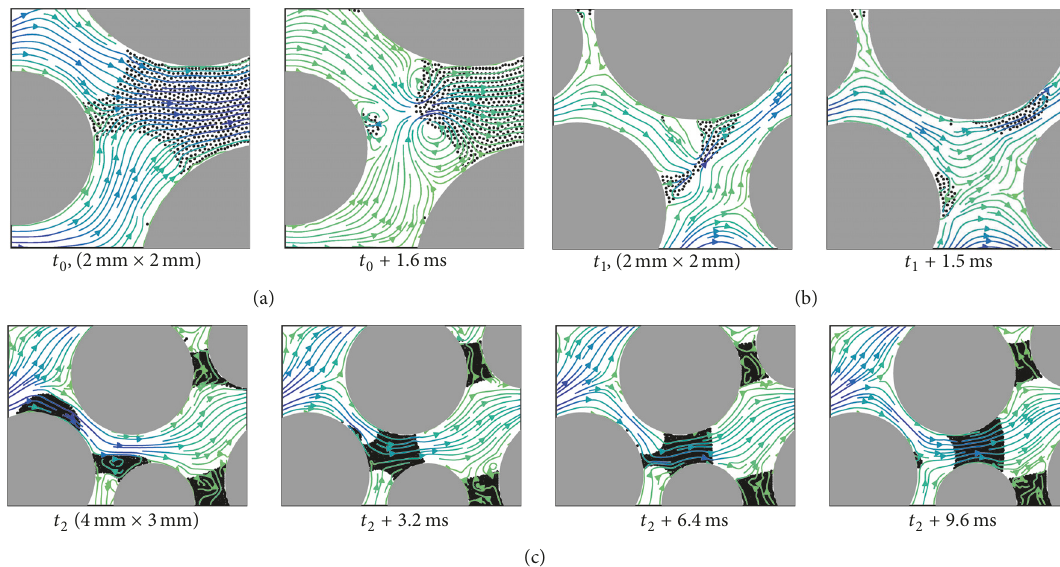
Figure 7: Pore-scale interfacial dynamics during stable displacement at log 10 ( Ca ,𝑀) = (−2,1) . Visual representation is equivalent to Figure 3. Spherical wetting cap formation due to menisci overlap near the saturation front ((a), 𝑡 0 ). Fragmentation of a pendular bridge into multiple wetting caps within the CDZ ((b), 𝑡 1 ). Wetting phase cluster mobilization by sequence of fragmentation and coalescence events within CDZ ((c), 𝑡 2